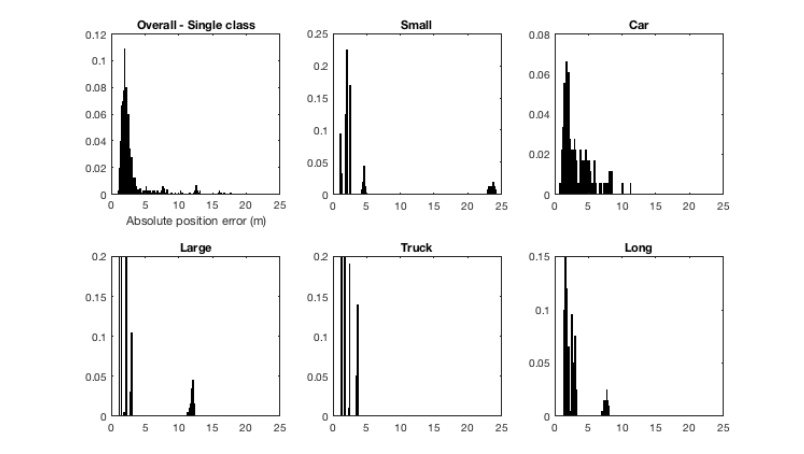
Figure 10. Normalised histograms for mean absolute position errors when considering all vehicles (traversing the roundabout having a central-island diameter of 40 m) as a single class versus categorising them into small, car, large, truck and long vehicles (for t tac = 3 s). Bin size for all the histograms is uniform. The y-axis has been left non-uniform for